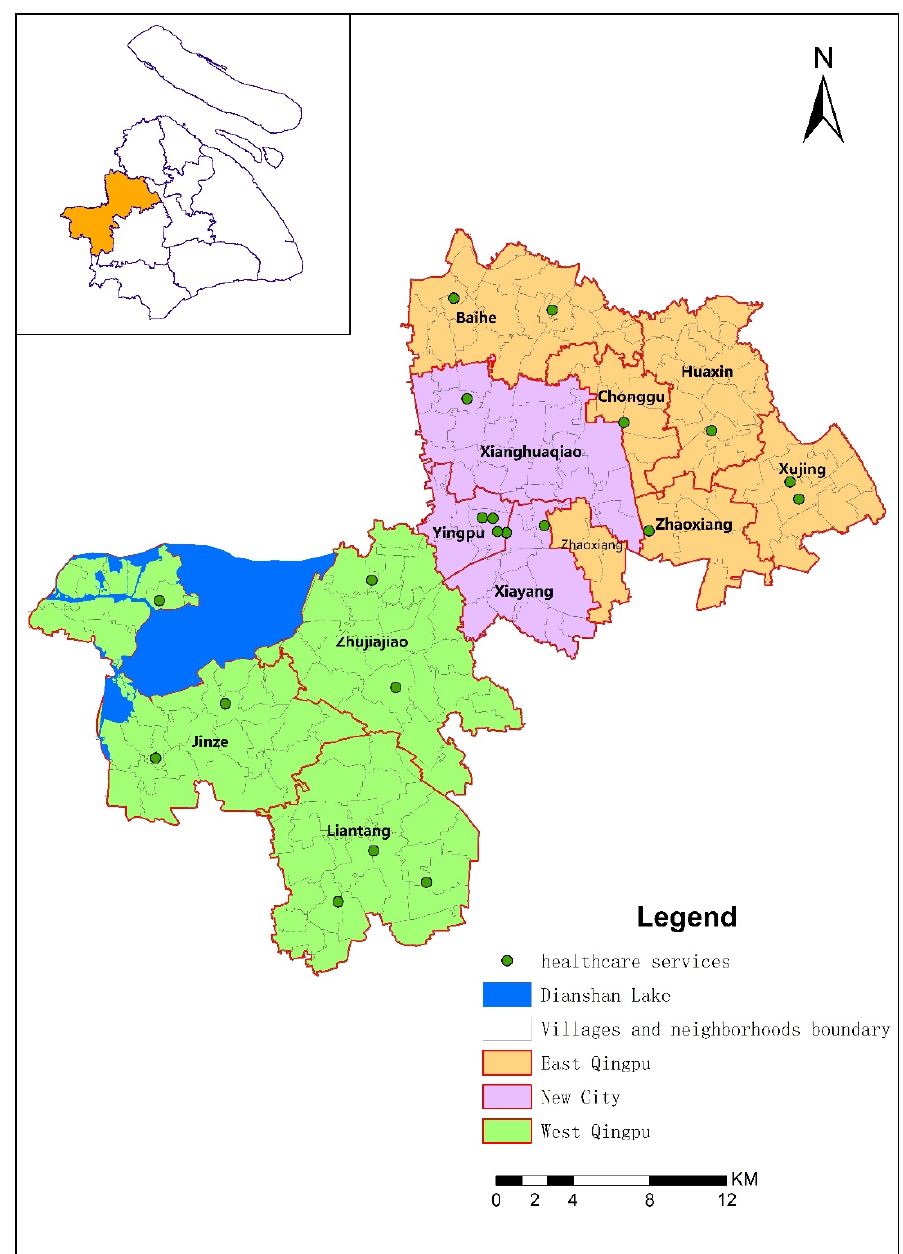
Figure 1. Sub-districts and healthcare services distribution in Qingpu.